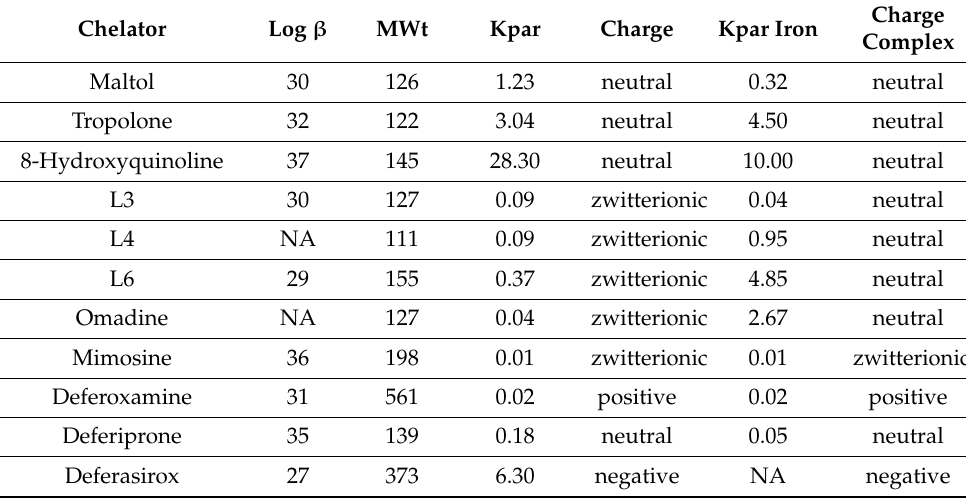
Table 4. Physicochemical properties of chelators and their iron complexes.